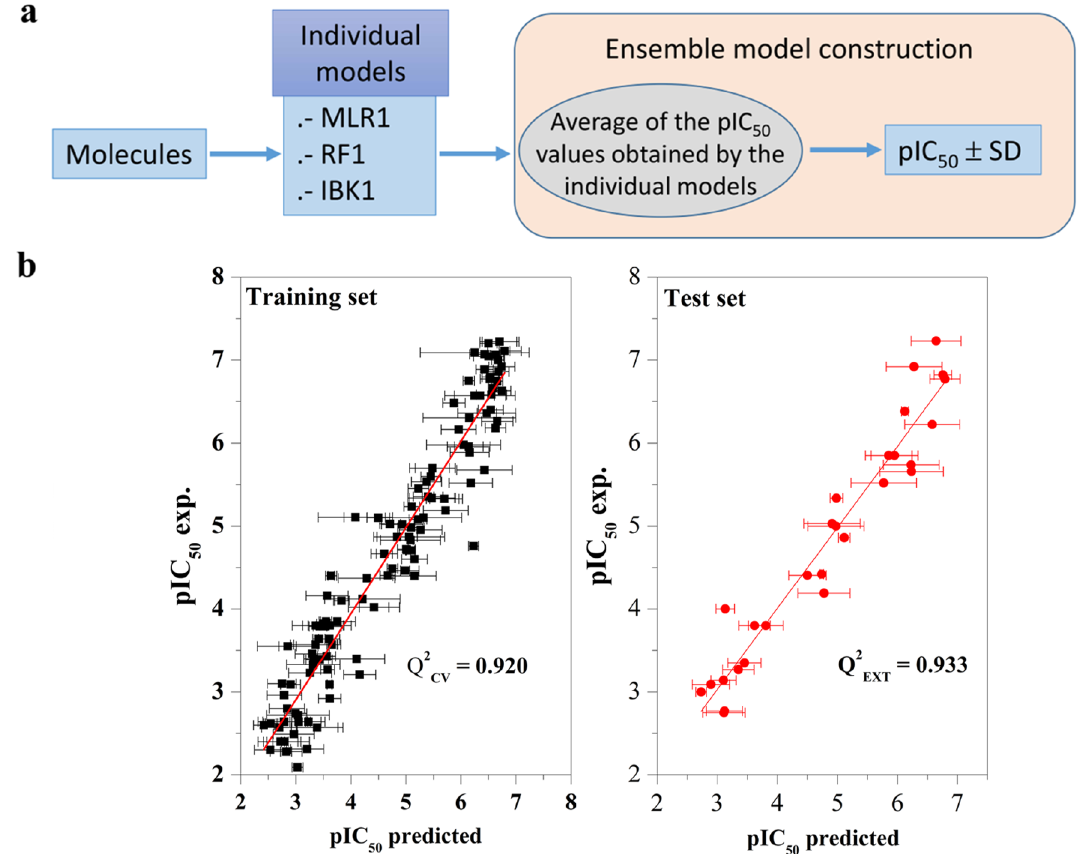
Figure 5. ( a ) Schematic representation for the ensemble construction procedure. ( b ) pIC 50 experimental vs. pIC 50 predicted the training and test sets obtained with the ensemble